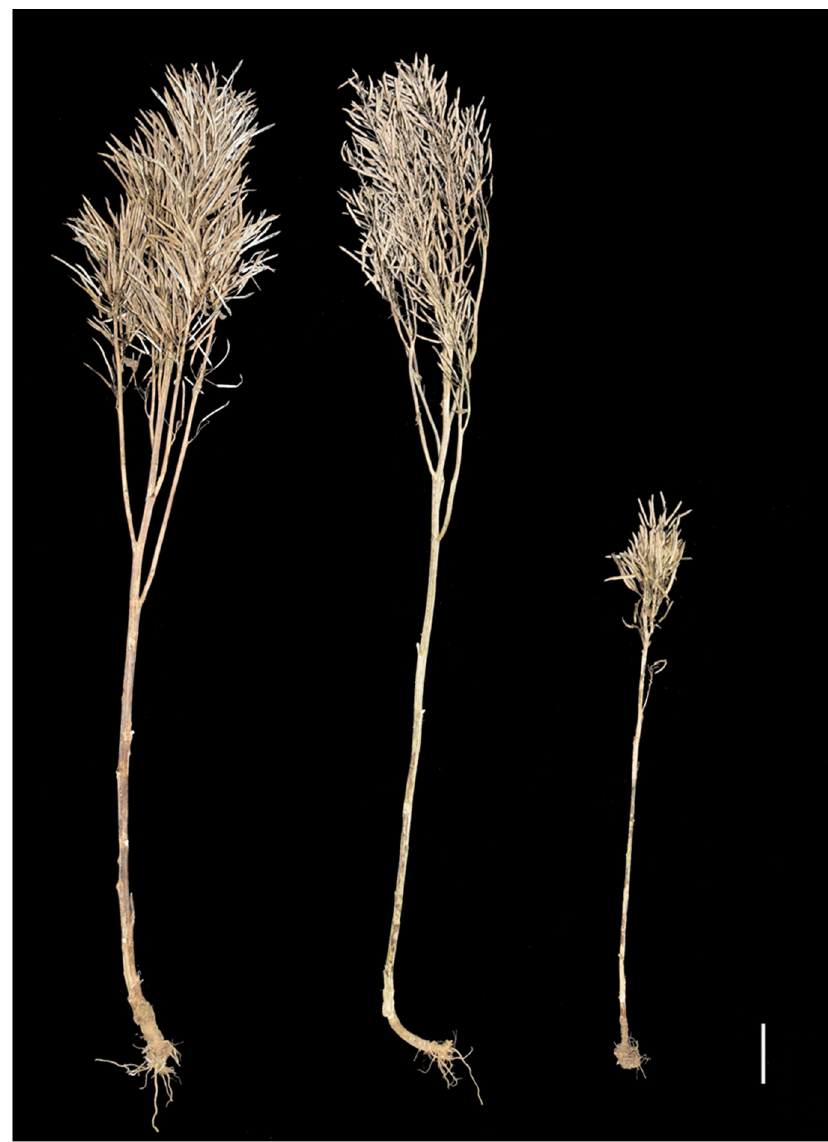
Figure 1. Plant architecture and height of the 8008 ( left ), 4942C-5 ( right ), and their F 1 ( middle ) individuals at the mature stage. Scale bar = 10 cm.